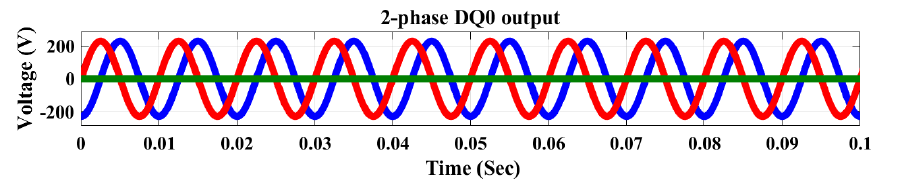
Figure 16. Two phase DQ0 output voltage of FSTPI